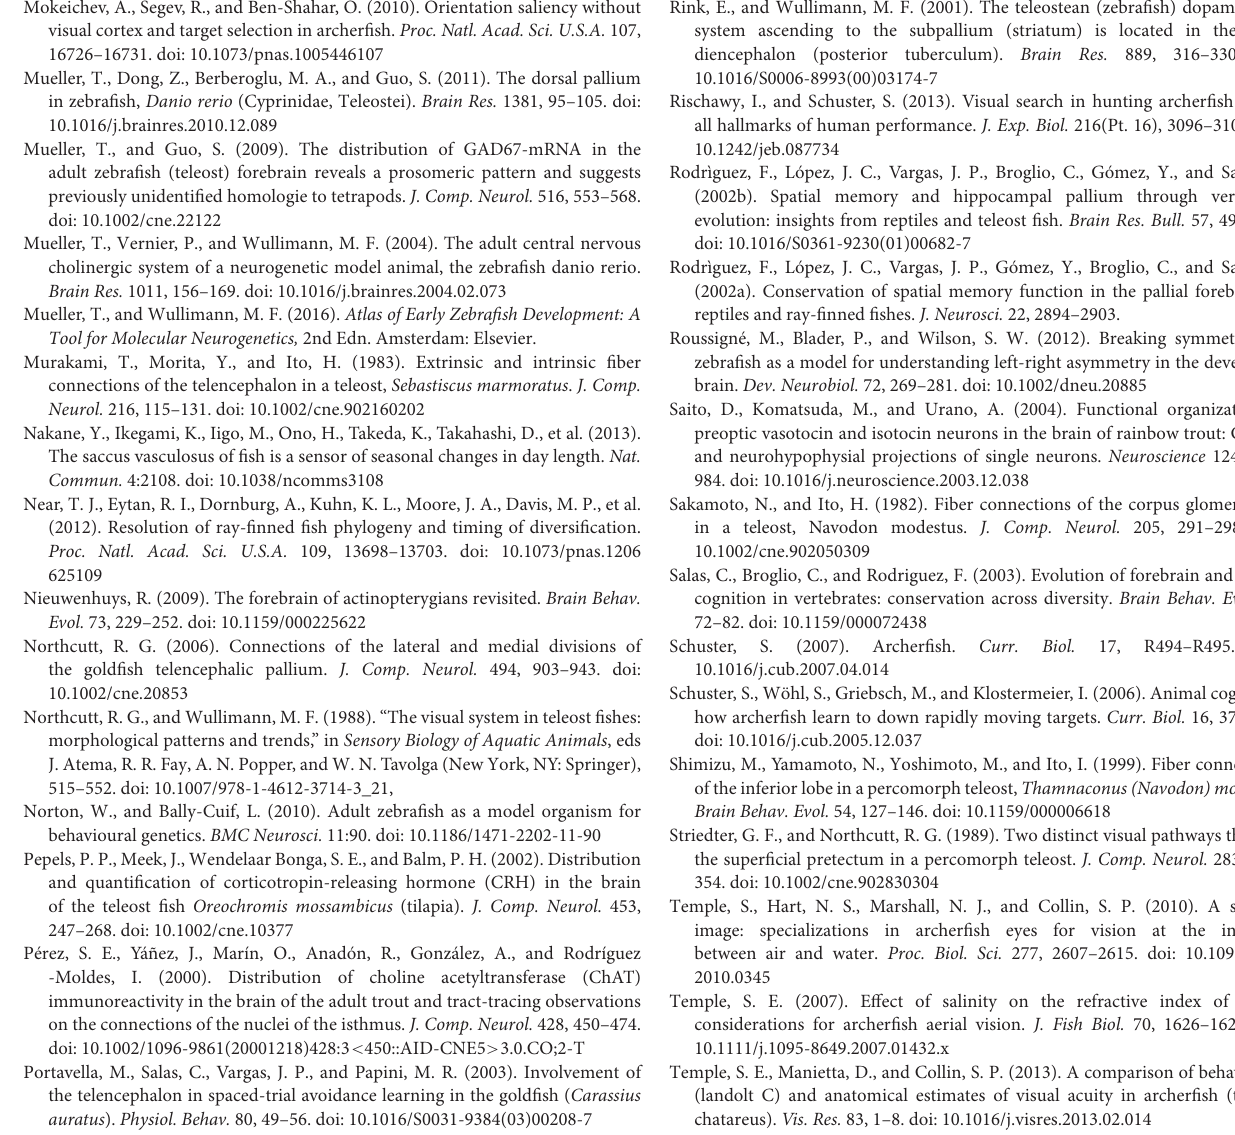
(landolt C) and anatomical estimates of visual acuity in archerfish (toxotes chatareus). Vis. Res. 83, 1–8. doi: 10.1016/j.visres.2013.02.014